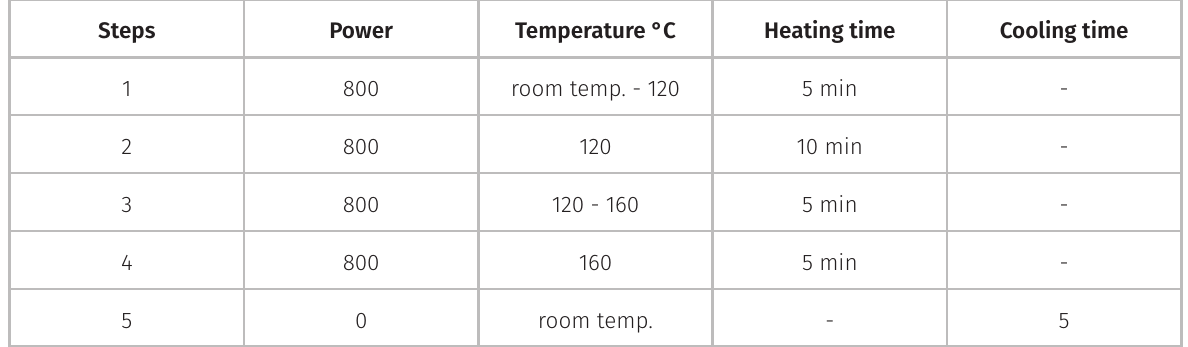
Table I. Operating conditions for the digestion of honey samples by microwave.